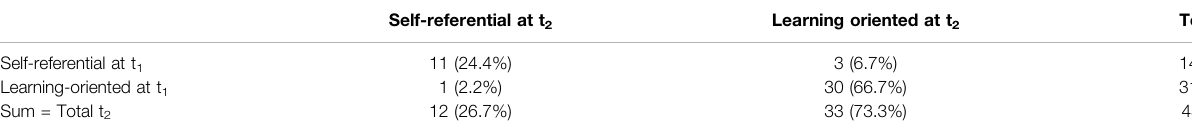
TABLE 5 | Number and percentage of metaphors for each category at both t 1 and t 2 , N (cid:1) 45. Self-referential at t 2